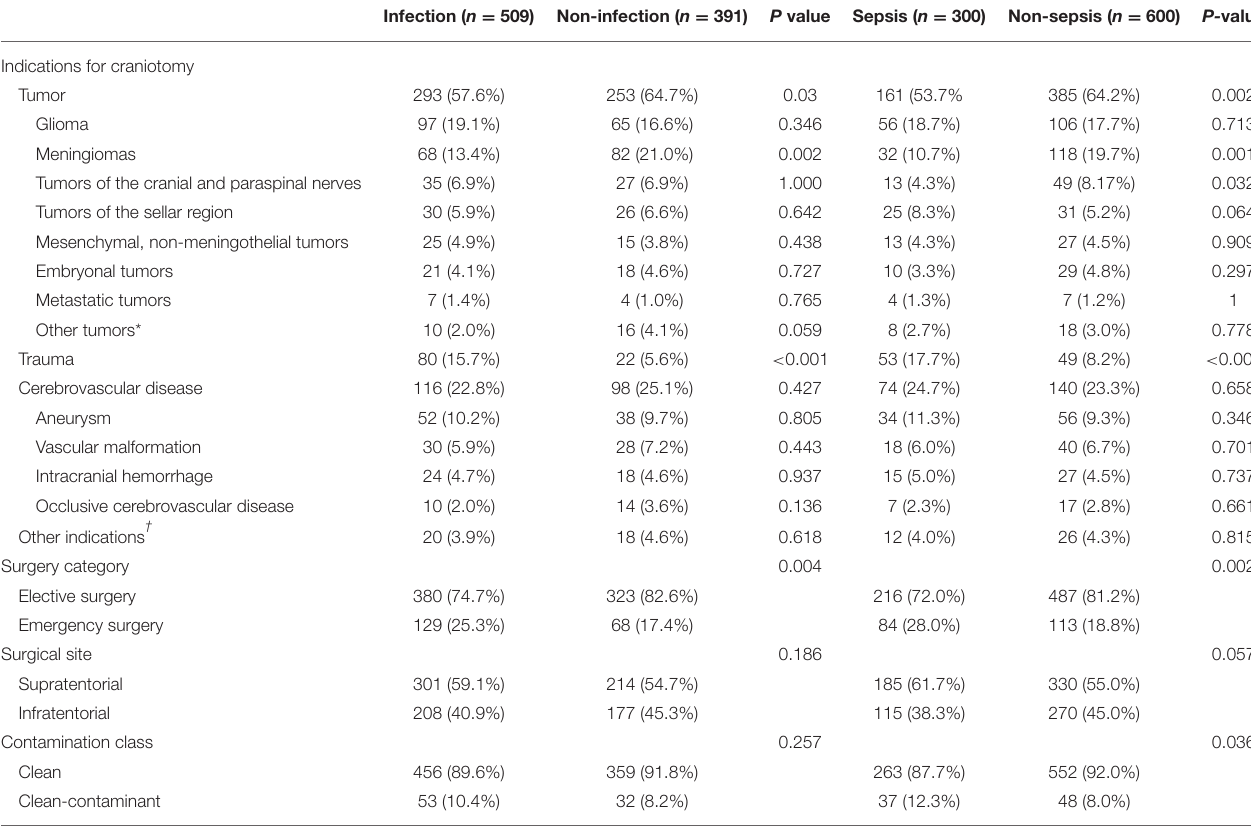
TABLE 2 | Indications for craniotomy, surgery category, surgical site, contamination class of surgical wound, and the corresponding incidence of infection and